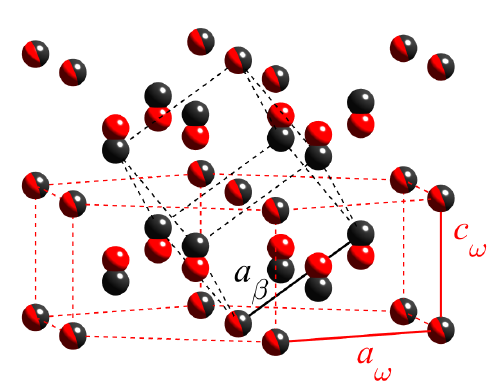
Figure 1. Sketch of the atomic positions of the body-centered cubic β phase (black) and hexagonal ω phase (red). The lattice parameters a β and a ω , c ω are denoted by full